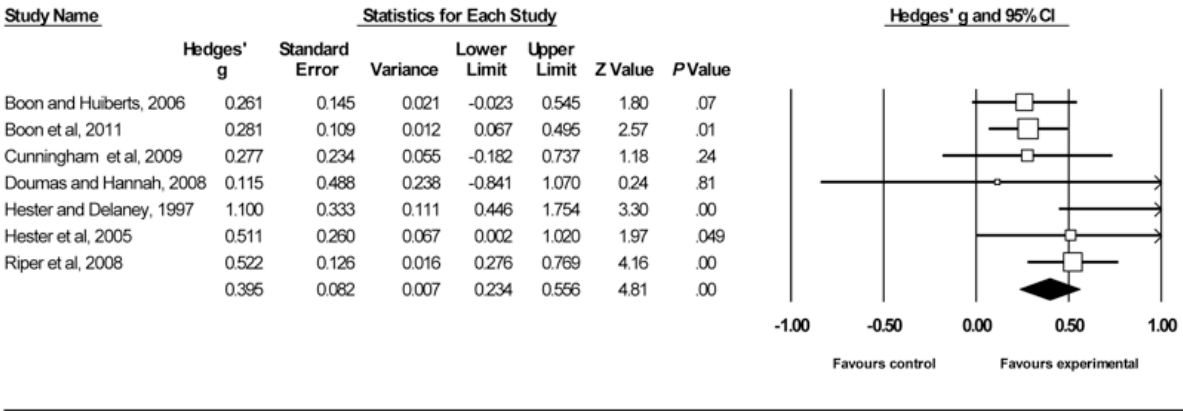
Figure 2. Meta-analysis of studies (omitting